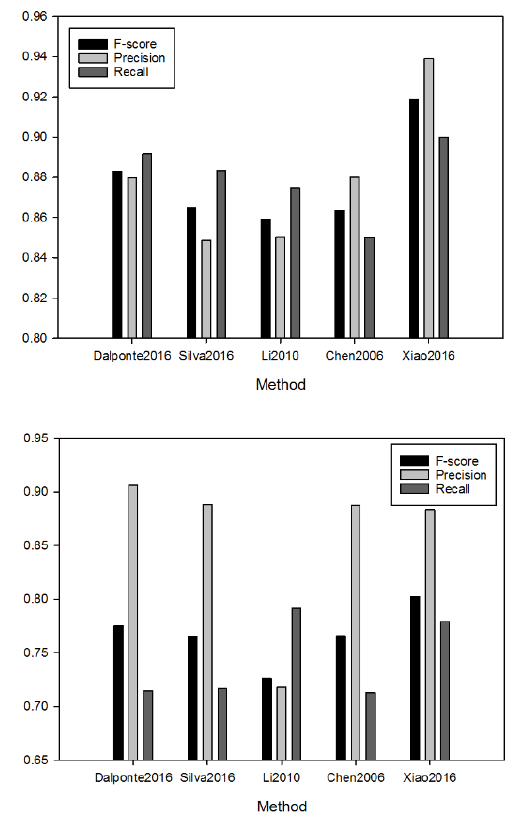
Figure 7. Average F-score, precision and recall for each algorithm averaged over all of the plots. Top: fine-tuned parameters, bottom: constant